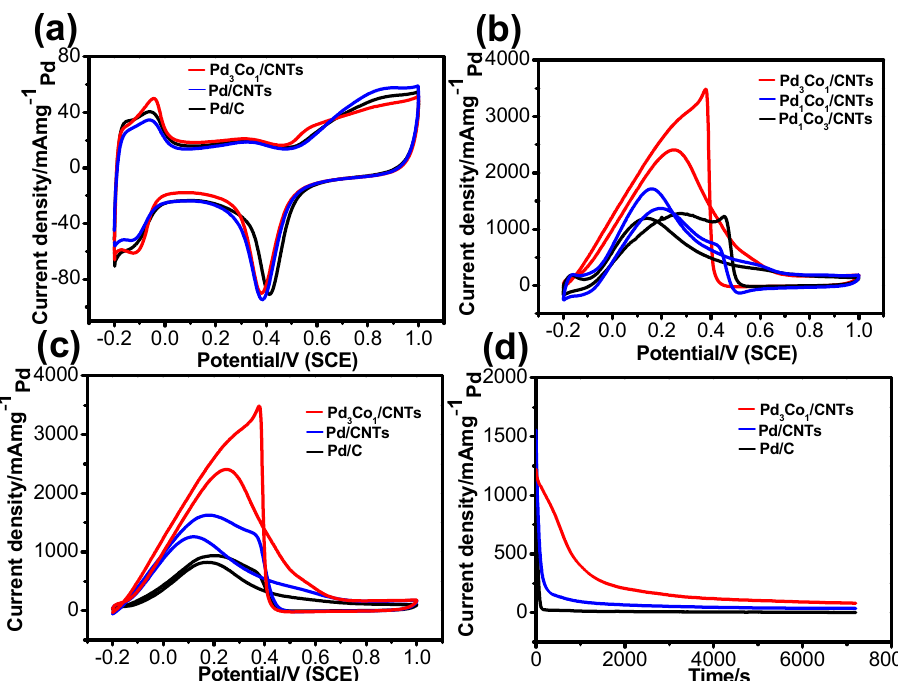
Figure 4. ( a , c ) Cyclic voltammograms and ( d ) current-time curves of Pd 3 Co 1 /CNTs, Pd/CNTs and Pd/C; ( b ) cyclic voltammograms curves of Pd 3 Co 1 /CNTs, Pd 1 Co 1 /CNTs and Pd 1 Co 3 /CNTs in 0.5 M H 2 SO 4 /1.0 M HCOOH + 0.5 M H 2 SO 4 solution.